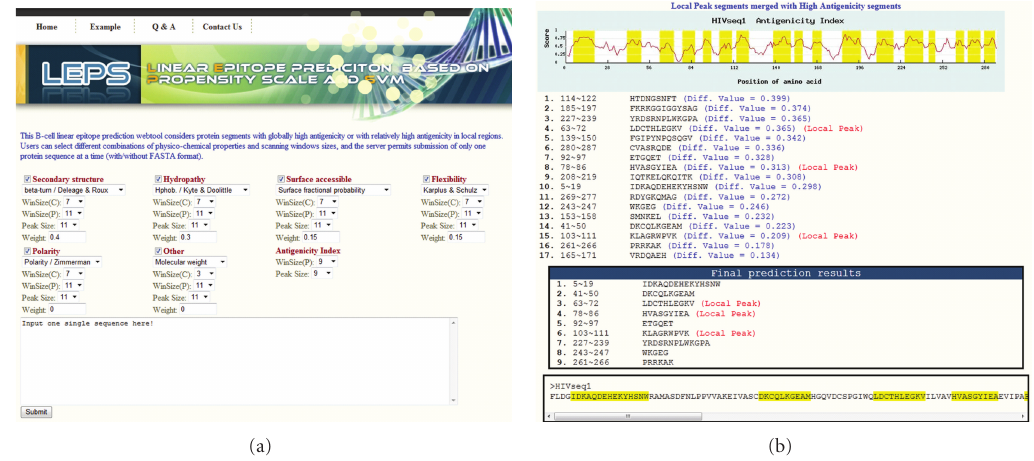
Figure 3: The LEPS server. (a) Users can input a query sequence and manually adjust the weight and window size of each propensity. (b) The output information of HIV integrase predicted by LEPS shows 17 candidates, and only 9 candidates were retained after SVM filtration. The final predicted epitope segments are labeled in yellow at the